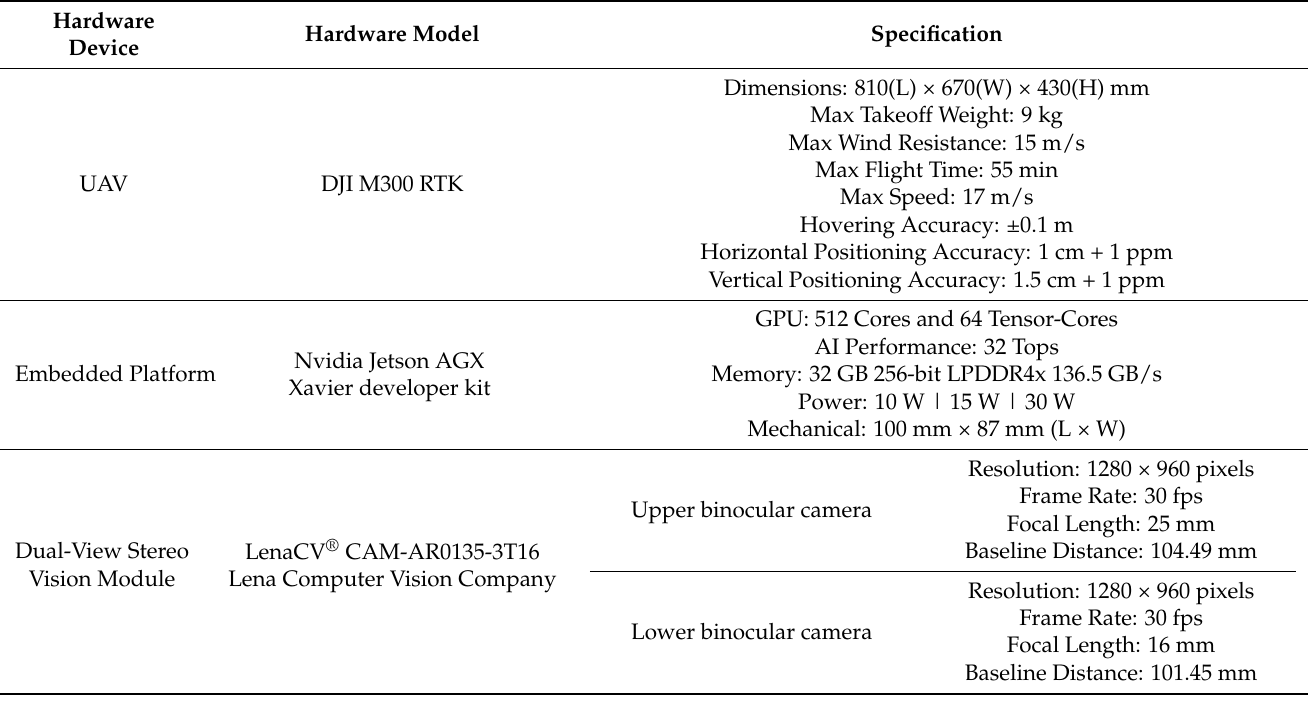
Figure 2. Overall framework of the proposed UAV-based inspection platform. Table 1. Details of the proposed inspection